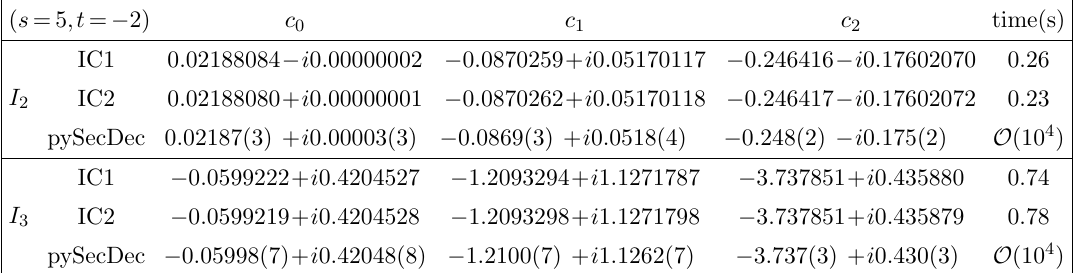
2). c 0 ;c 1 (cid:0)